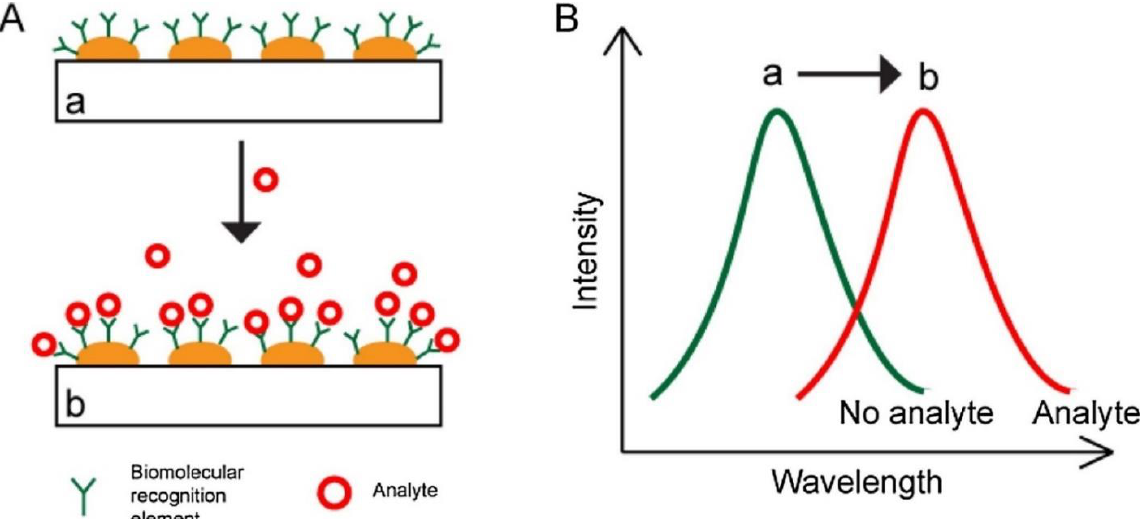
Figure 6. LSPR biosensing principle. ( A ) Biomolecular recognition elements (e.g., antibody) on the surface of metal nanosubstrate (a) recognize and capture analytes (e.g., antigens) present in a liquid sample, (b) producing a local increase in the refractive index at the metal surface. ( B ) The increase in local refractive index induces a peak-wavelength shift of the extinction spectra. Figure adapted from